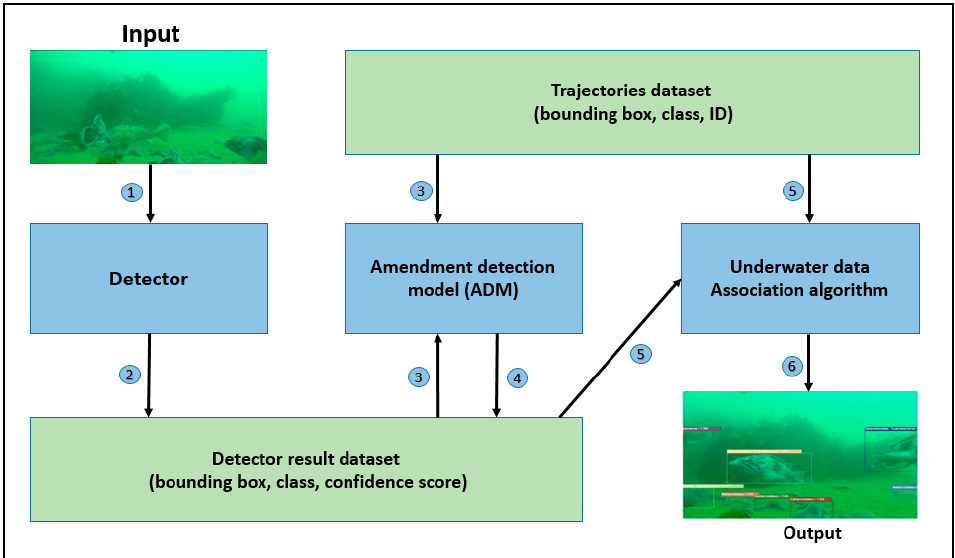
Figure 1. Flow chart of the FSTA. It comprises three modules, a detection result set, and a tracking result set.